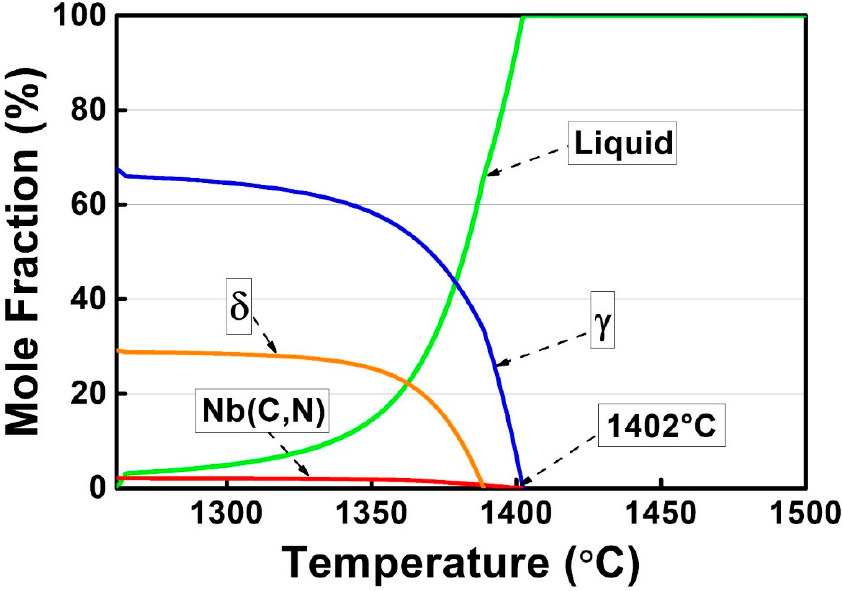
Figure 3. Mole fractions of different phases that formed during the liquid–solid solidification of alloy 3C2N, calculated by JMatPro software under the Scheil–Gulliver condition.